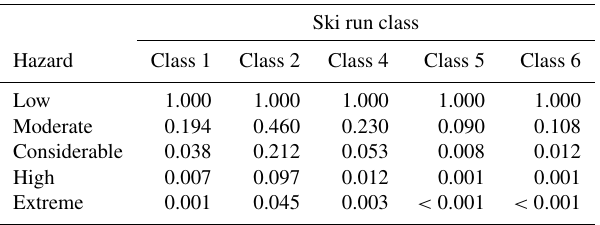
Table 4. Odds ratios of each ski run class being open with increas- ing avalanche hazard relative to low avalanche